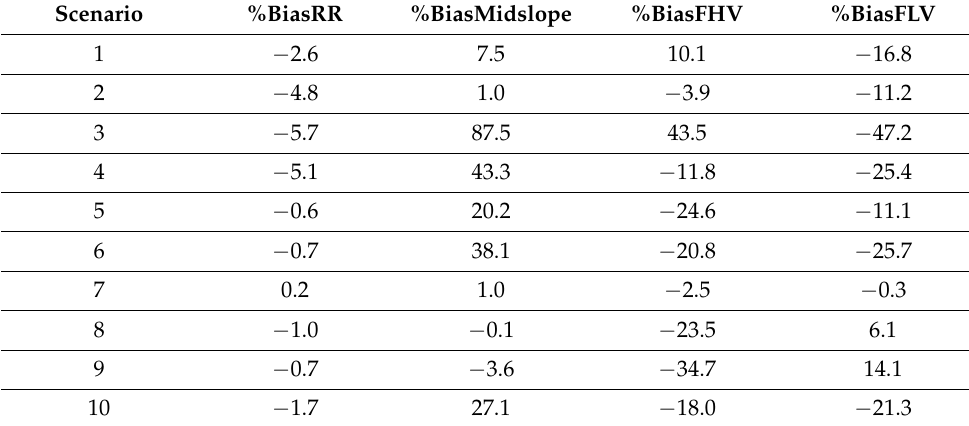
Table 6. Signature indices of the 10 scenarios compared to the baseline scenario; evaluation